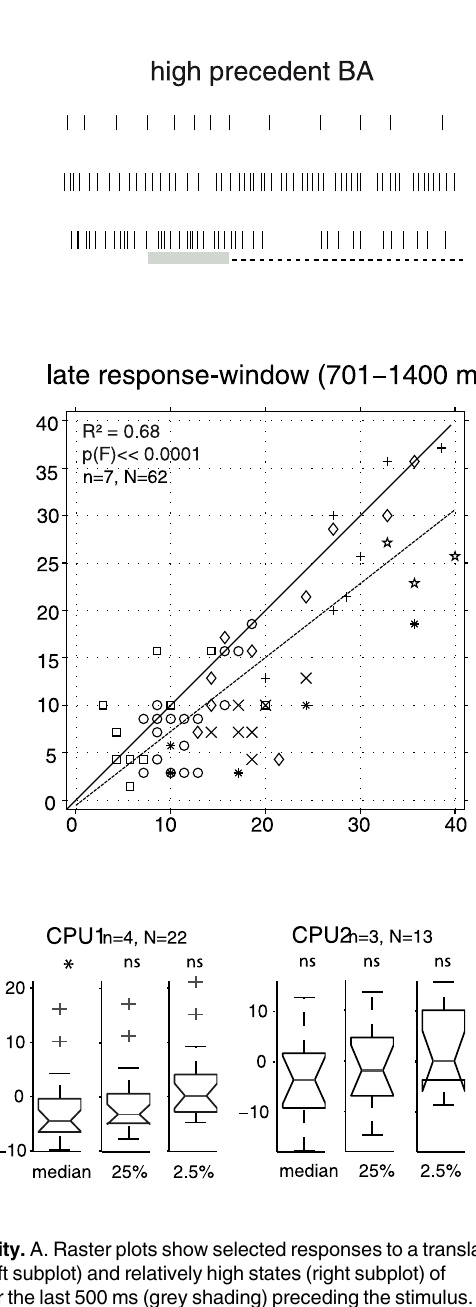
PLOS ONE | DOI:10.1371/journal.pone.0144501 December 4,